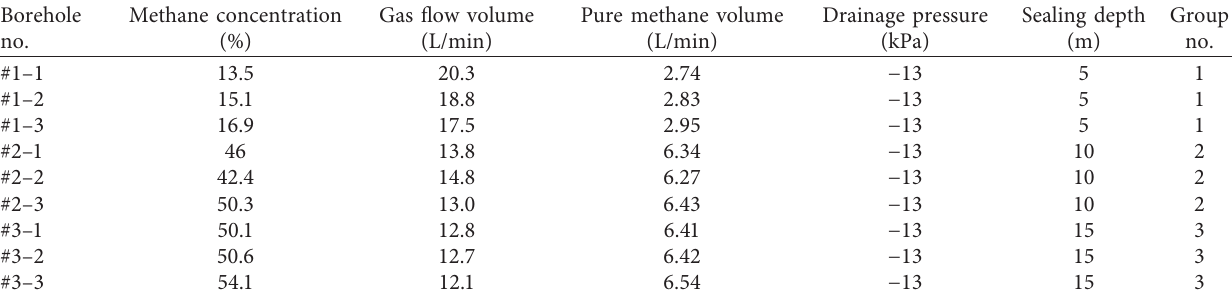
Figure 18: Curves of gas concentration in boreholes at monitor line 3. Table 5: Drainage results of each test borehole.